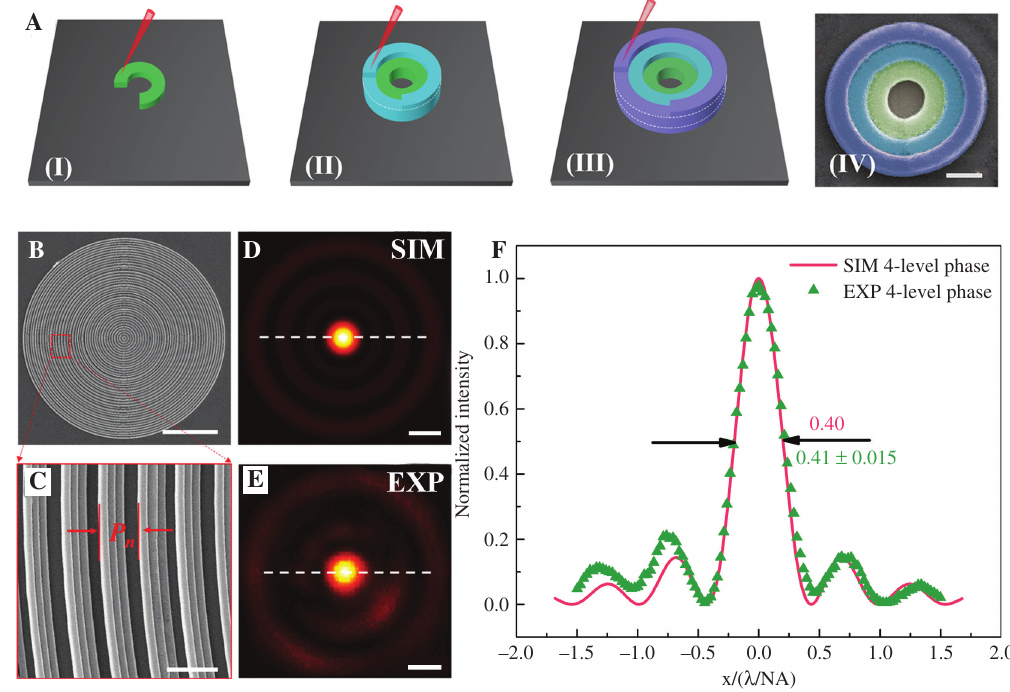
Figure 4: Multi-level phase SCL. (A) Schematic representation of the fabrication procedure of the four-level phase SCL supercell. The sub-belts with different